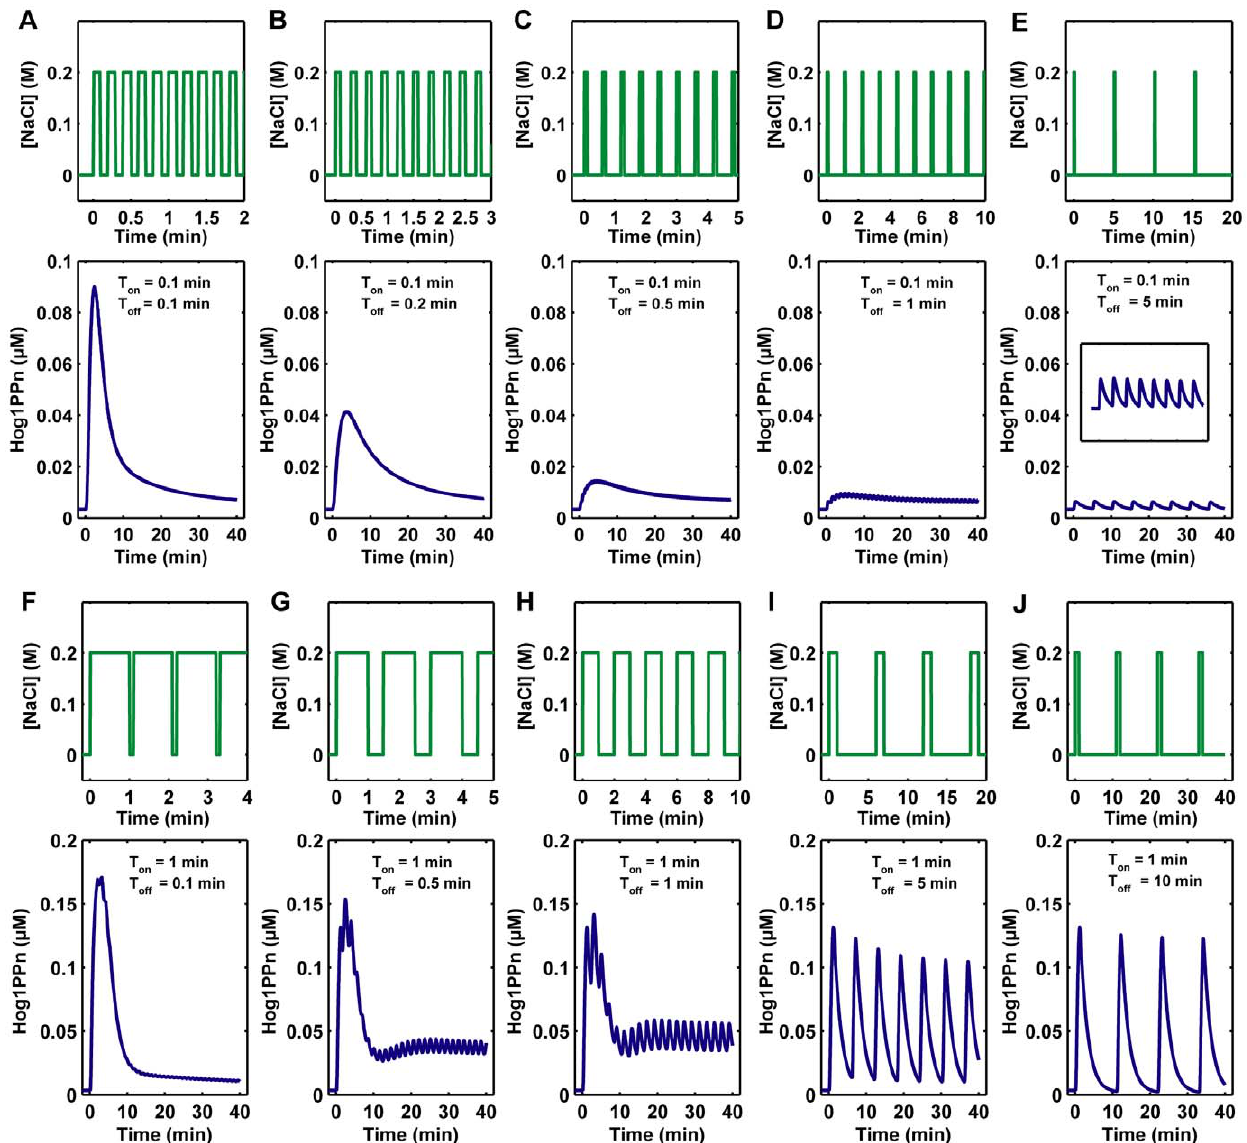
Figure 8. Nuclear phosphorylated Hog1 (Hog1PPn) response to different periodic square pulses of 0.2 M NaCl. ( A–E ) The time of pulse in on phase (T on =0.1 min) of periodic square pulses is very short, while the time of pulse in off phase (T off ) of periodic square pulses varies from 0.1 min to 5 min. The intersection curve in low part of panel E is a zoom-in of Hog1PPn response in different scale. ( F–J ) The time of periodic square pulse in on phase (T on =1 min) is long enough to induce Hog1PPn response, the time of periodic square pulse in off phase (T off ) varies from 0.1 to 10 min.